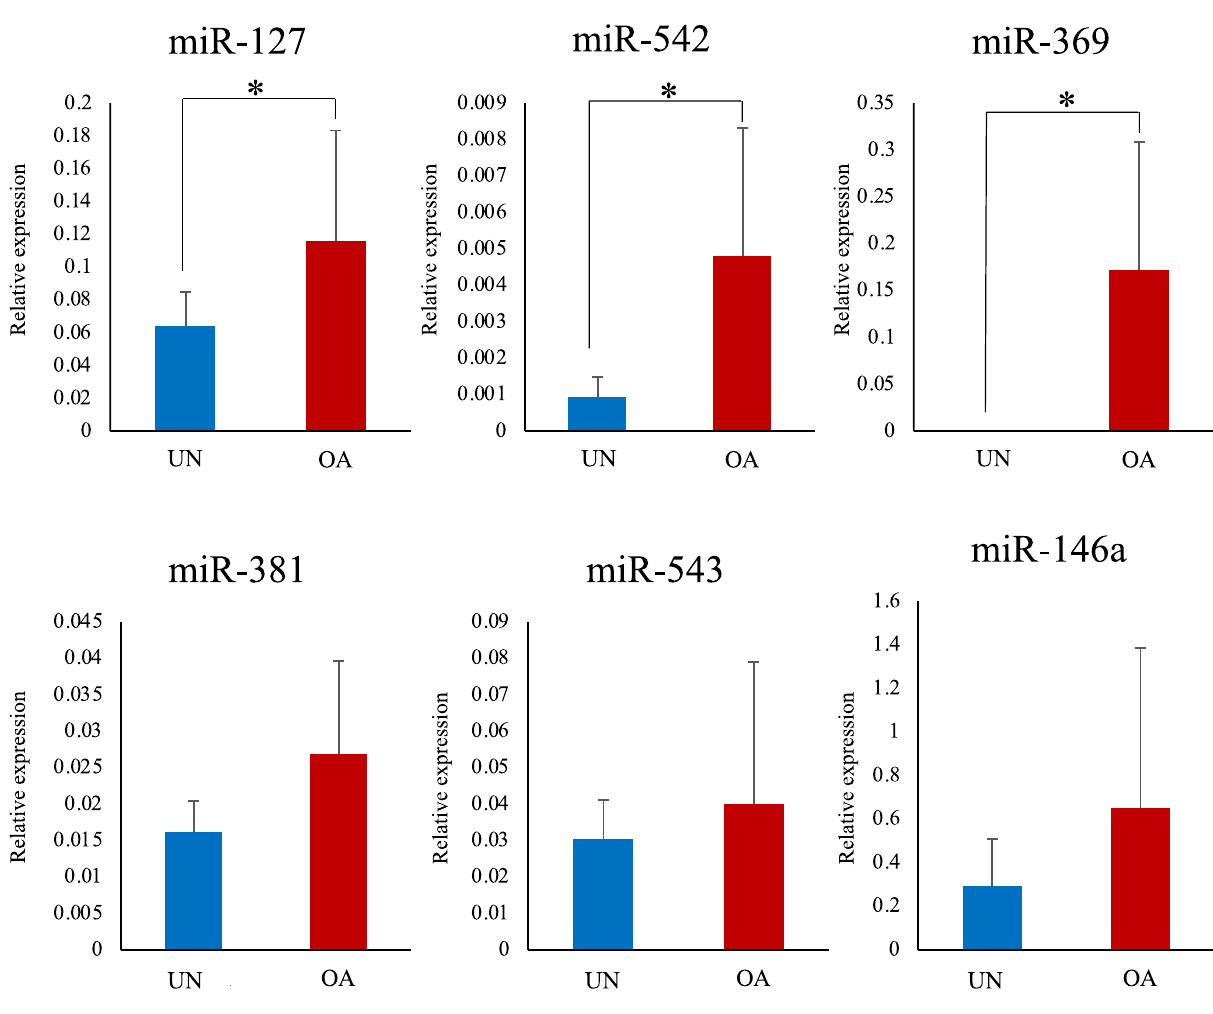
Figure 6. Comparison of miRNA expression levels in the synovial tissue between the two groups. The relative expression levels of each miRNA in the synovium in the osteoarthritis (OA) group and the unaffected group were compared. The data are presented as mean ± standard deviation. UN, unaffected group; OA, osteoarthritis group. *: Mean values differ significantly between the groups ( p <